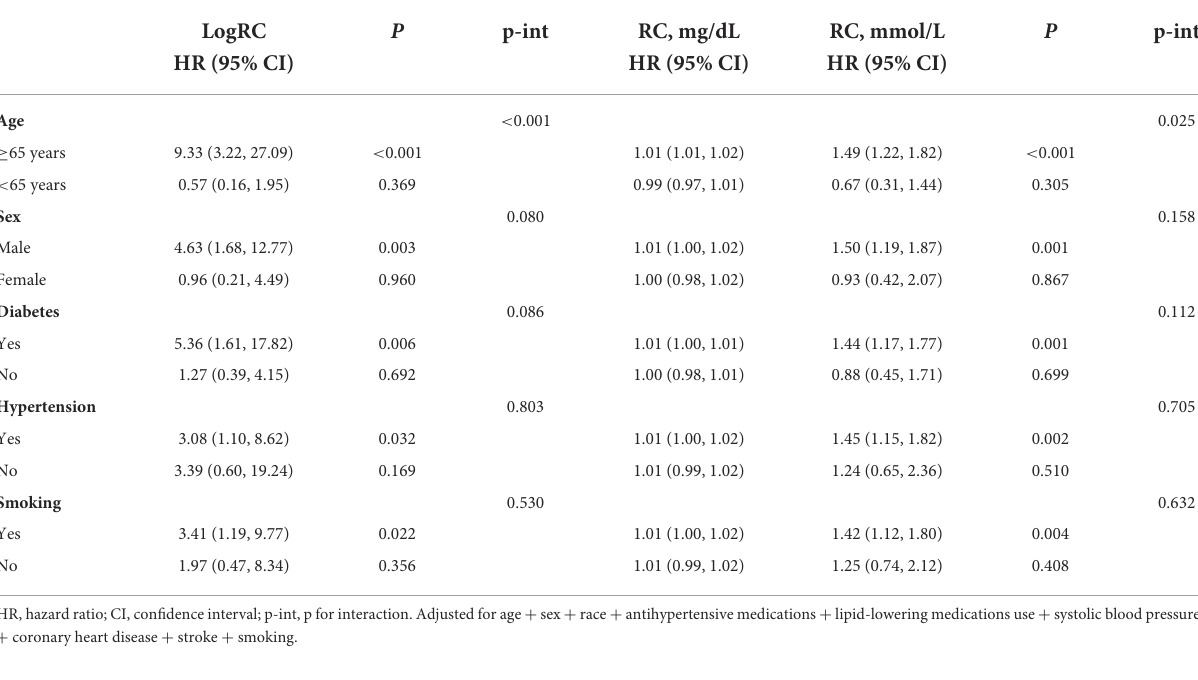
TABLE 4 Subgroup analysis for cardiovascular mortality for logRC and RC (continuous variables).